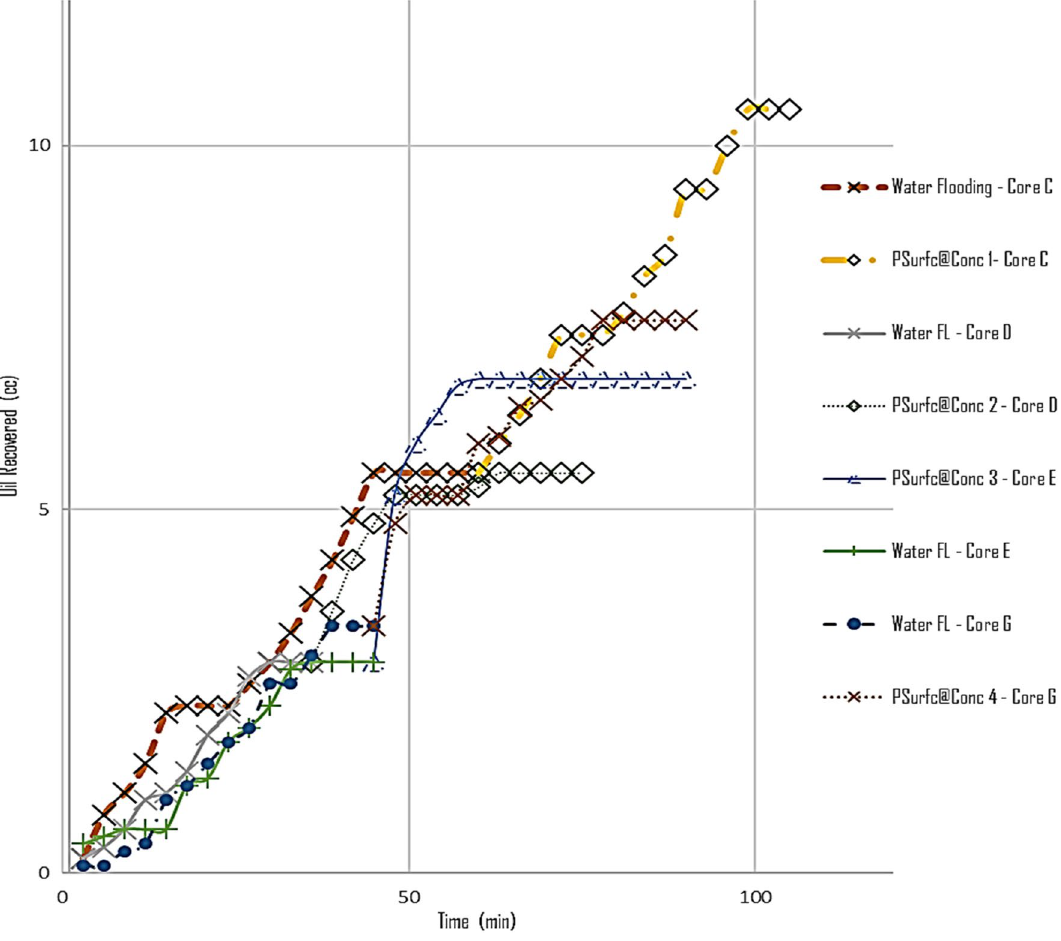
Fig. 11 Flooding experiment performed using three core samples (Core C, Core D and Core E) at different PSURFC concentrations: experimen- tal condition: flooding temperature at 28 °C, constant rate of 2.0